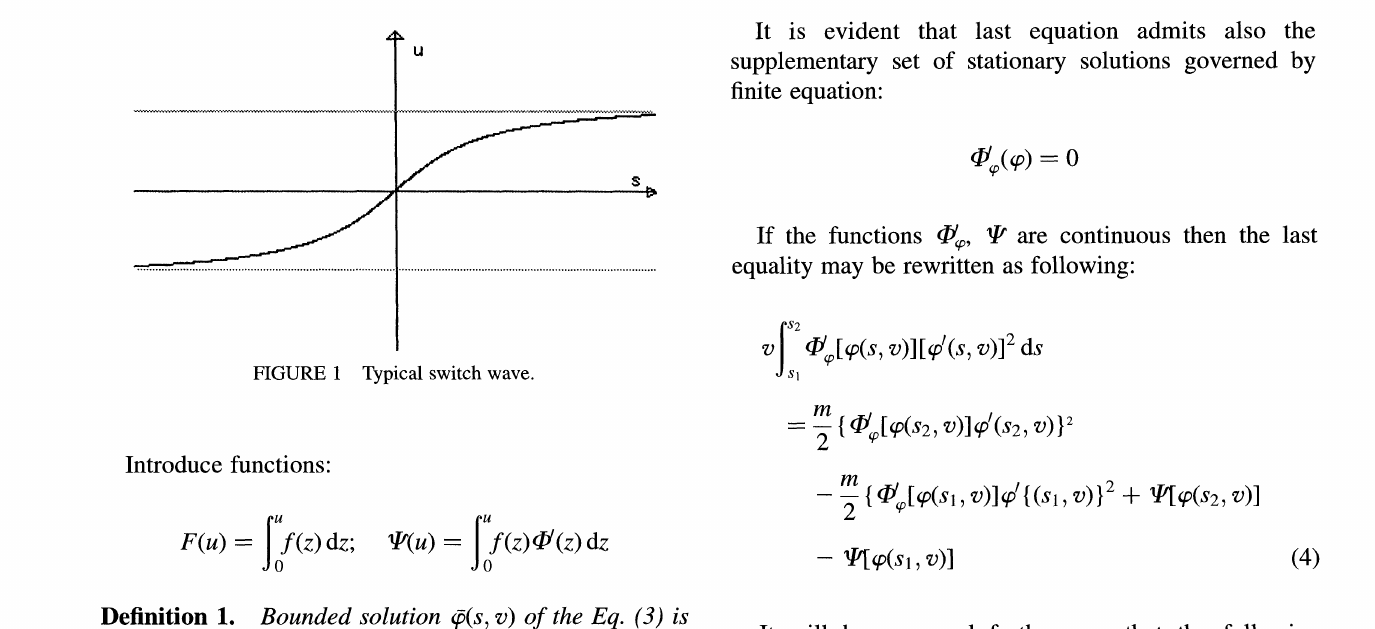
FIGURE Typical switch wave.